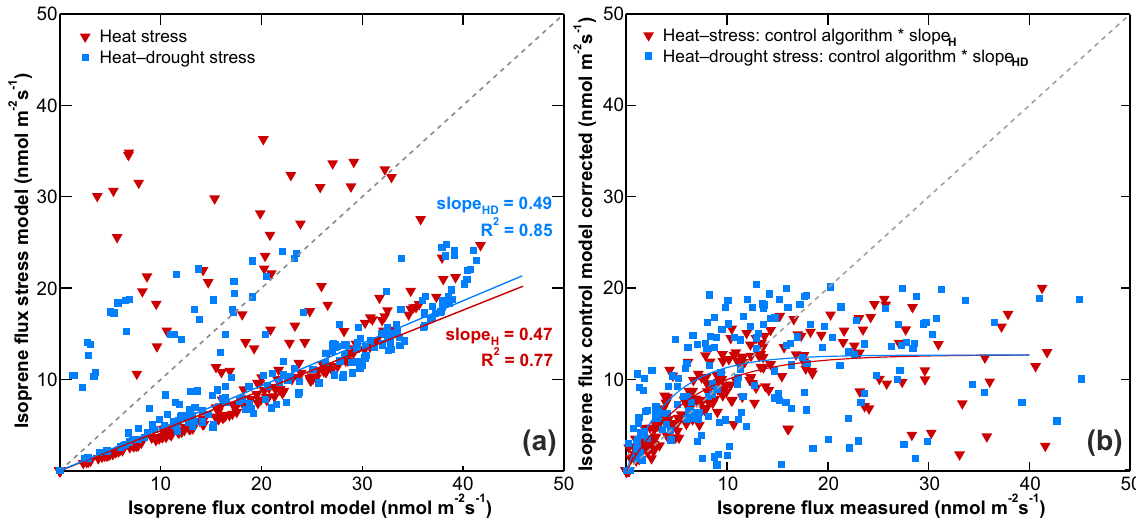
Figure 7. (a) Isoprene fluxes of heat and heat–drought-stressed trees modeled with the stress algorithm against fluxes modeled with the control algorithm including a linear least-square fit showing the slope which would bring fluxes calculated with the control algorithm in line with fluxes calculated with the stress algorithm. (b) Isoprene fluxes modeled with the control algorithm and corrected with the slope denoted in S1a to account for changes in the standard isoprene emission rate during